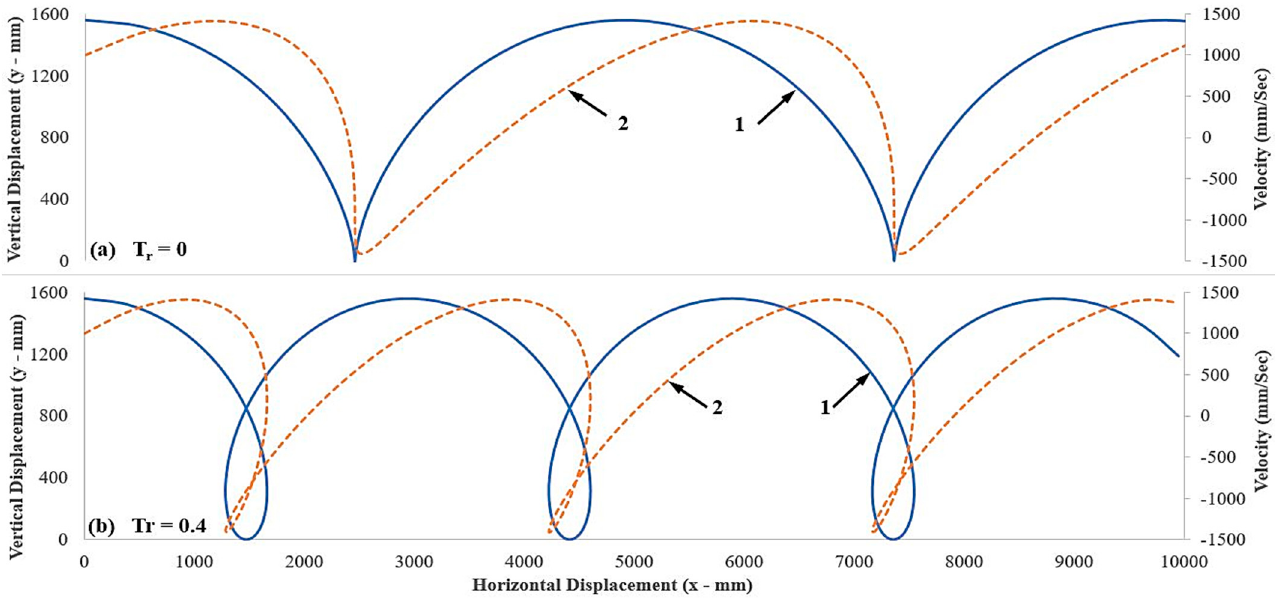
Figure 8. Relationships of vertical displacement and velocity of lug edge point M at different travel reduction rates (a) 0, and (b) 0.4, and corves 1 and 2, represent vertical displacement and velocity respectively.